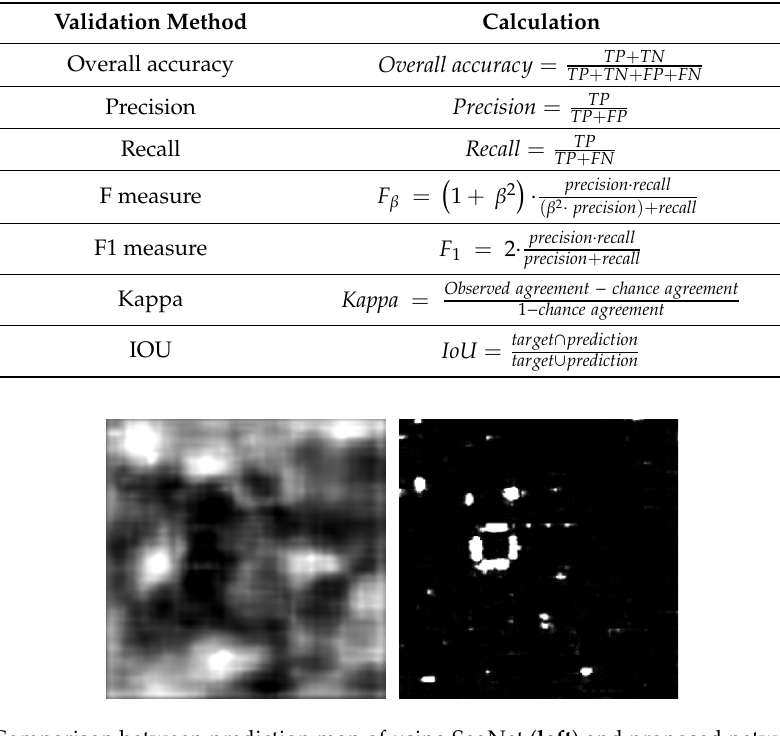
Figure 5. Comparison between prediction map of using SegNet (left) and proposed network (right).